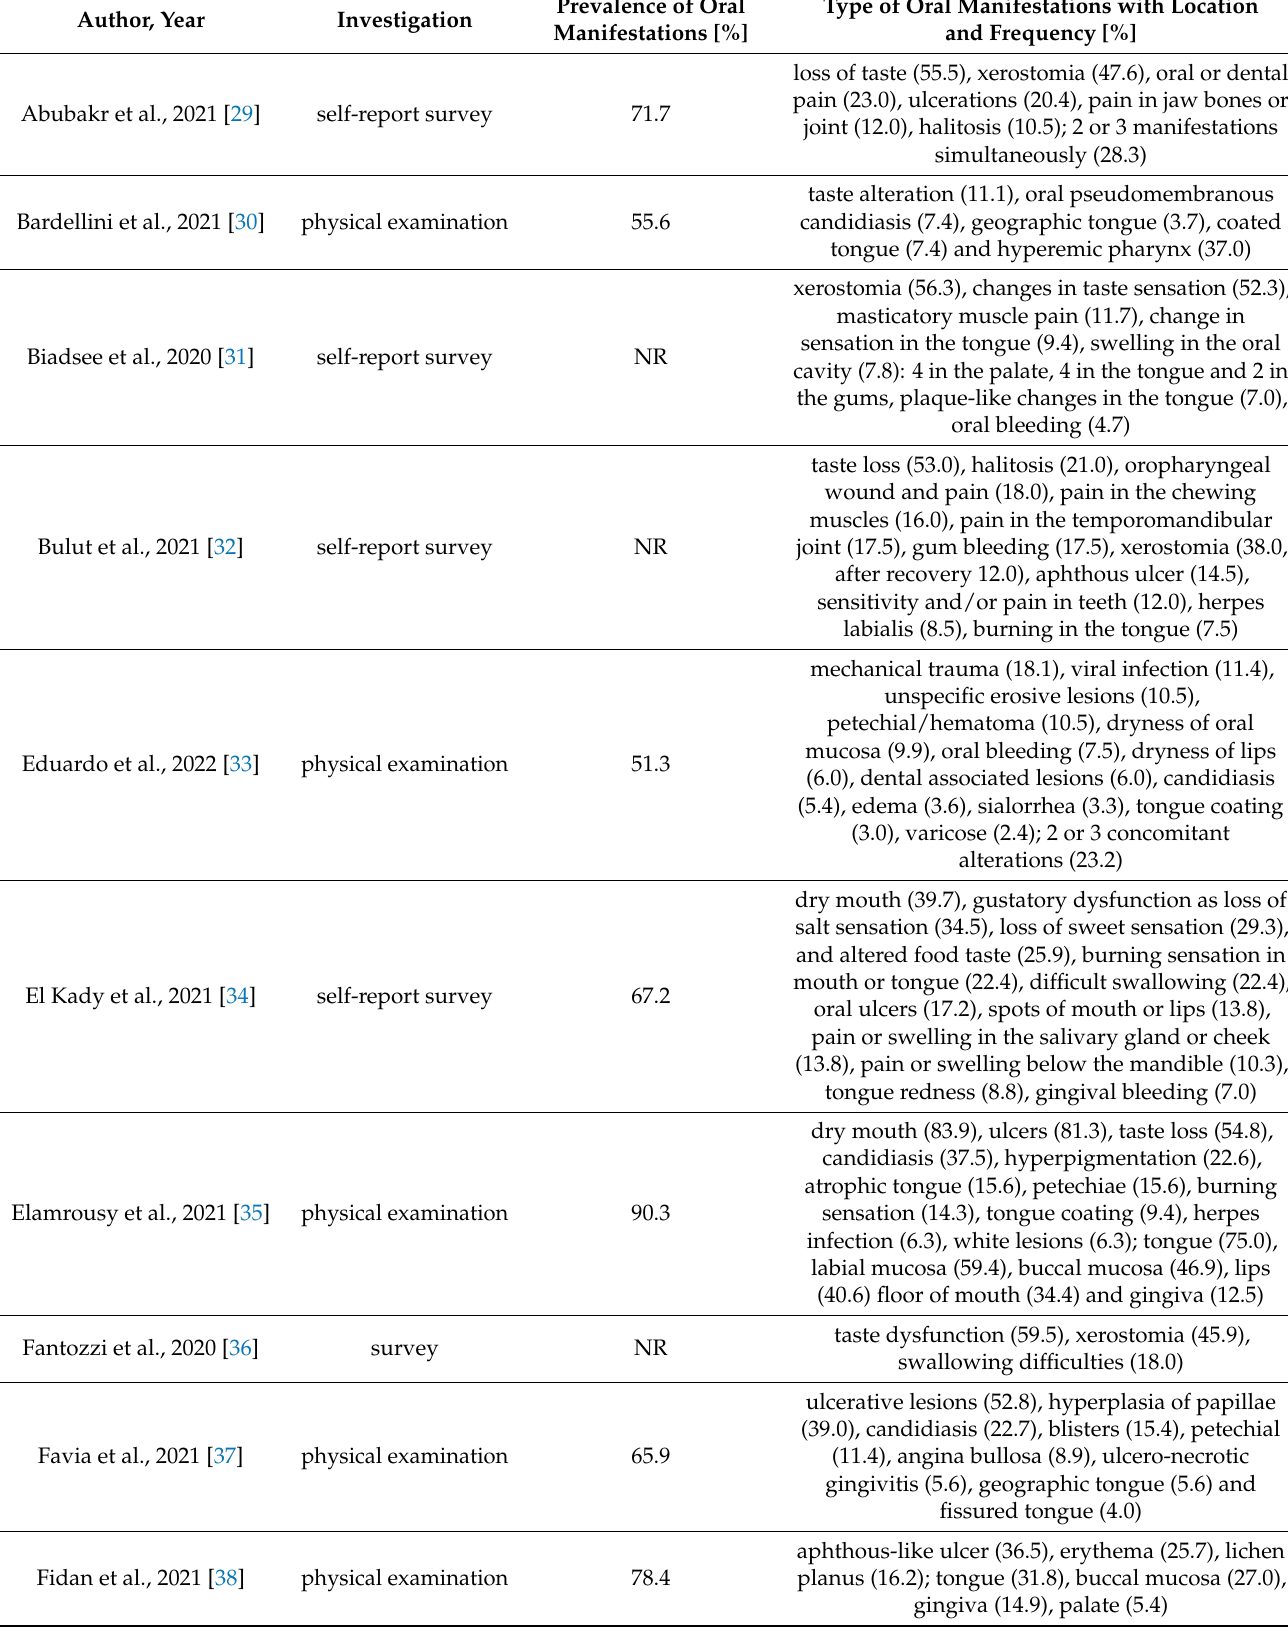
Table 3. Detailed characteristics of included studies considering oral